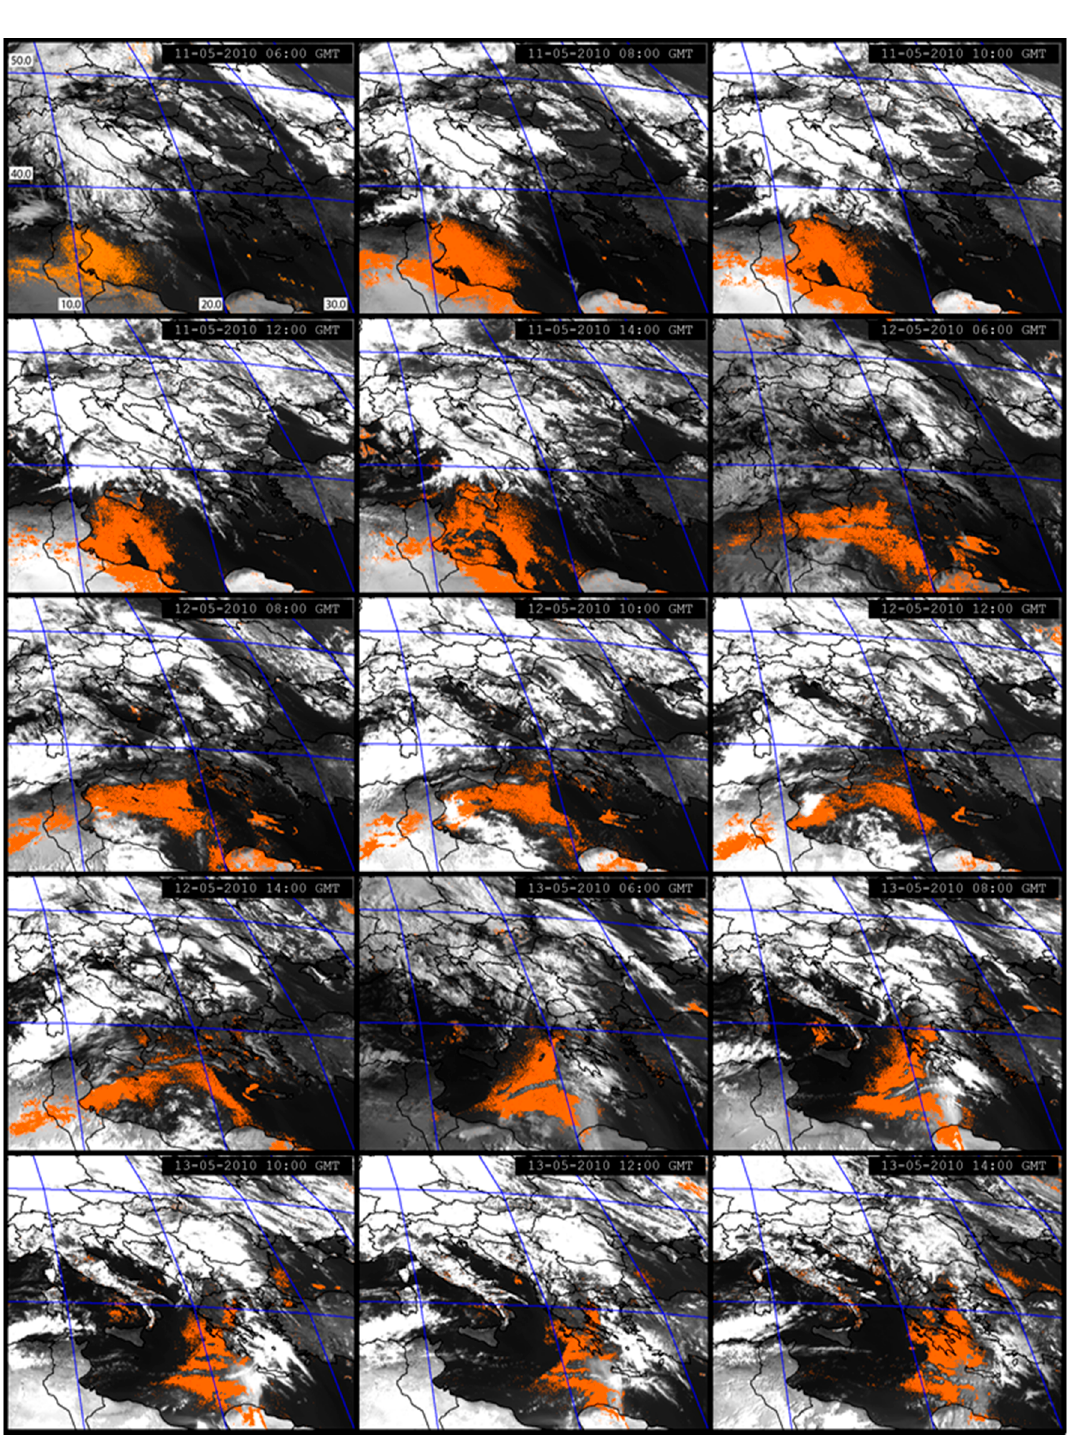
Figure 10. e RST DUST maps (at two hours) generated by the processing of the daytime SEVIRI data of 11 May 2010 at 06:00 UTC–13 May at 14:00 UTC (visible channel is displayed in background) showing, in orange, the detected dusty pixels (with ⊗ VIS ( x,y,t ) > 0 ( L ), 1 ( S ) AND ⊗ TIR ( x,y,t ) > − 2 AND ⊗ Δ TIR ( x,y,t ) < − 1).